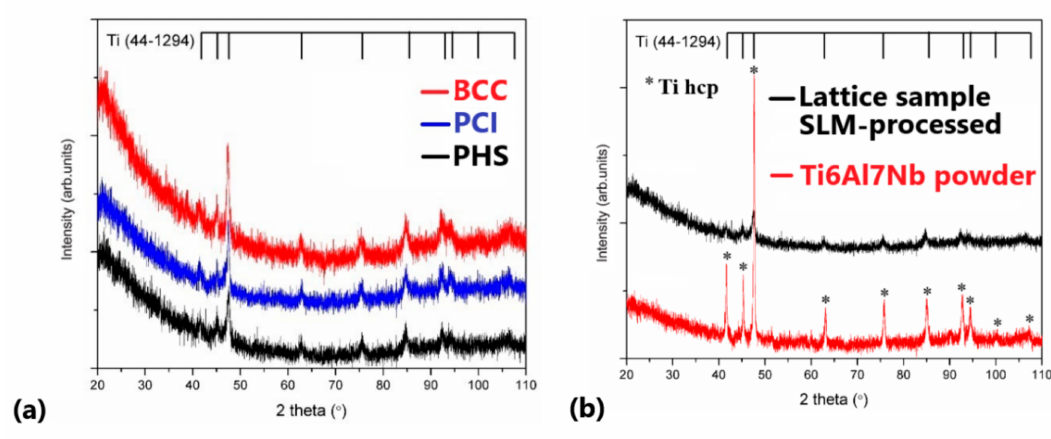
Figure 7. Optical micrographs of PCI specimens, longitudinal sections: ( a ) columnar grains orientation; ( b ) crack propagation after compressive test marked with orange arrow; colored arrows indicate construction pores (Kroll’s reagent)—micro-void (purple arrow), micro-crack (blue arrow), gaseous bubble (red arrow), and binding defect (green arrow).